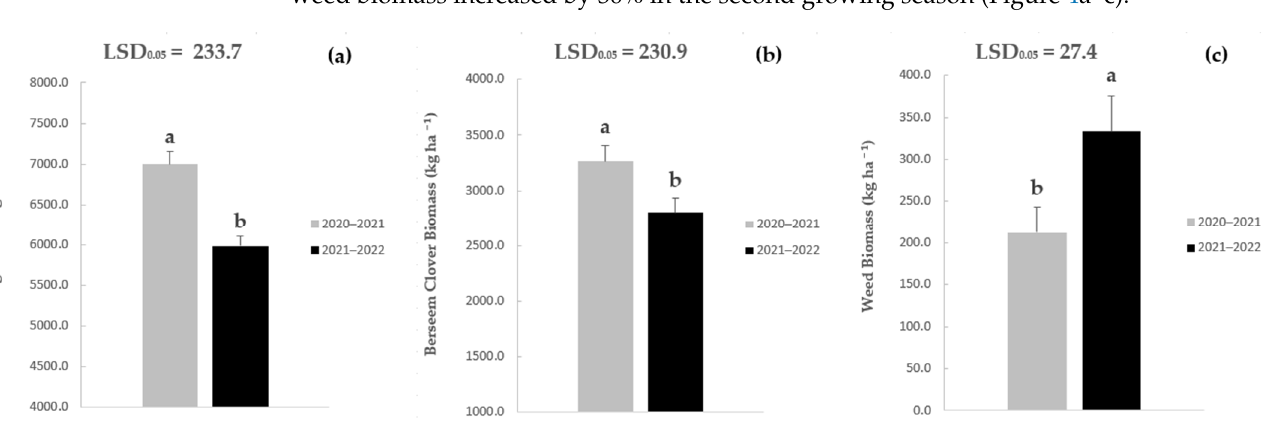
Figure 4. ( a ) Forage yield (kg ha −1 ), ( b ) biomass of berseem clover (kg ha −1 ), and ( c ) weed biomass (g m −2 ) in the first harvest of 2020–2021 and 2021–2022. Numbers followed by different letters are sig- nificantly different. Vertical bars indicate standard errors.